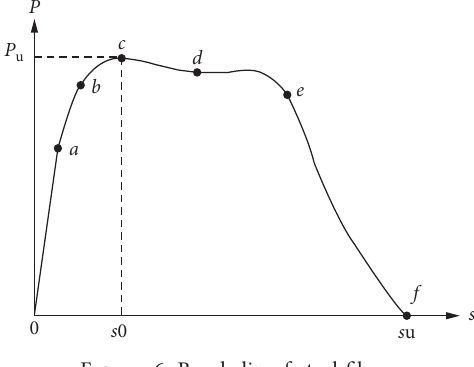
Figure 6: Bond slip of steel